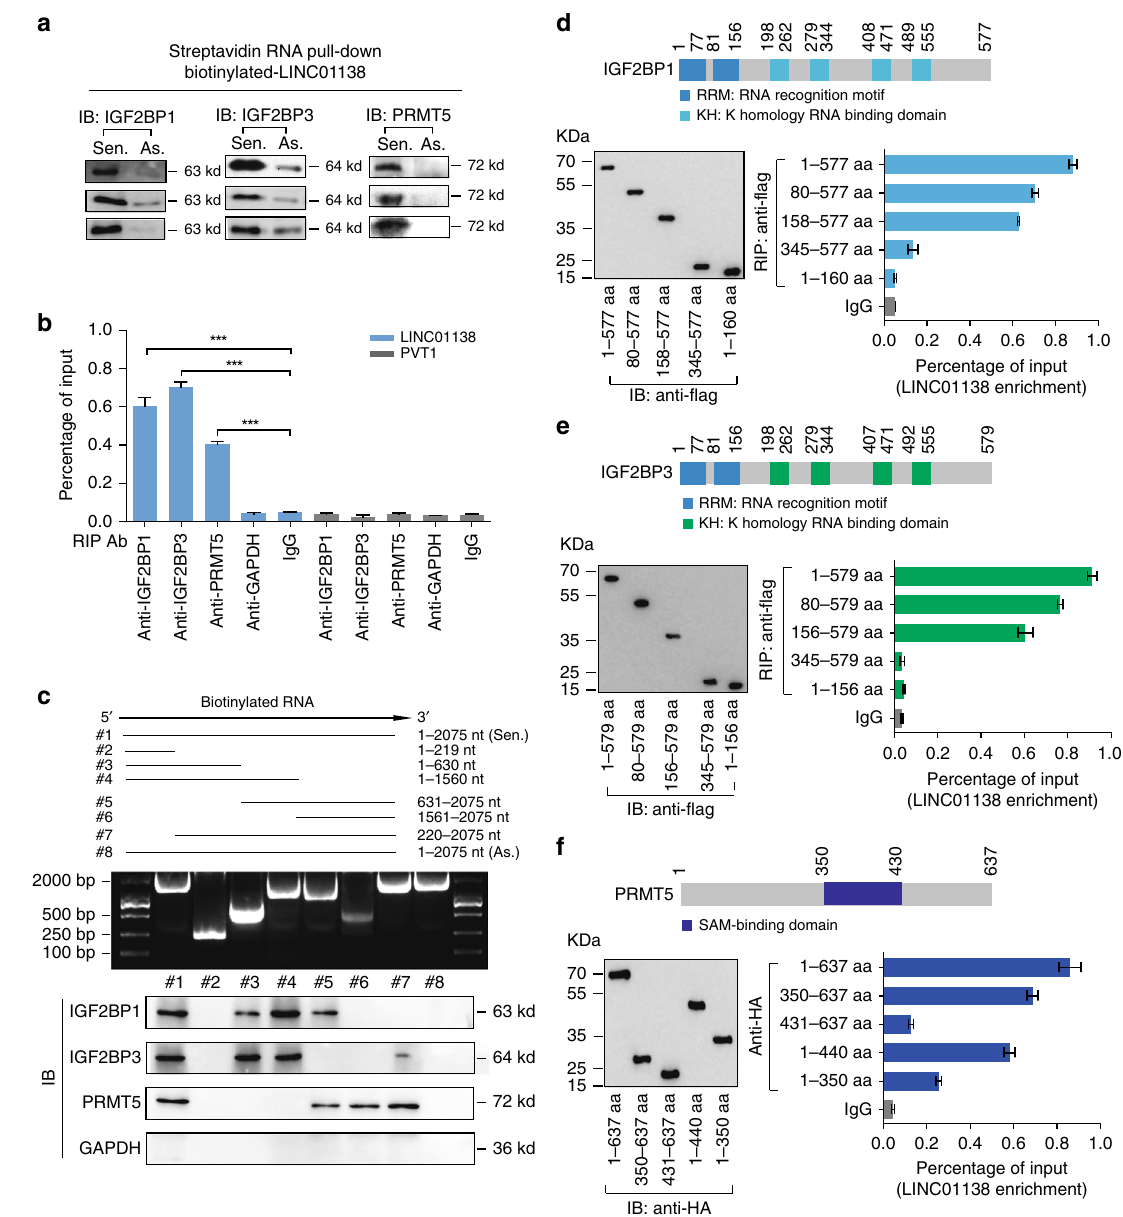
Fig. 3 LINC01138 physically interacts with IGF2BP1, IGF2BP3 and PRMT5 in HCC cells. a Immunoblotting for the speci fi c associations of IGF2BP1, IGF2BP3 or PRMT5 with biotinylated-LINC01138 from three independent streptavidin RNA pull-down assays. b RIP assays were performed using the indicated antibodies. Real-time PCR was used to detect LINC01138 enrichment, using GAPDH antibody as the antibody control and 2036-nt PVT1 as the LincRNA control. c Immunoblotting of IGF2BP1, IGF2BP3 or PRMT5 in pull-down samples by full-length biotinylated-LINC01138 (#1) or truncated biotinylated- LINC01138 RNA motifs (#2: 1 – 219 nt; #3: 1 – 630 nt; #4: 1 – 1560 nt; #5: 630 – 2075 nt; #6: 1560 – 2075 nt; #7: 220 – 2075 nt), with GAPDH as the negative control. d – f Deletion mapping for the domains of IGF2BP1 ( d ), IGF2BP3 ( e ) or PRMT5 ( f ) that bind to LINC01138. RIP analysis for LINC01138 enrichment in cells transiently transfected with plasmids containing the indicated FLAG-tagged or HA-tagged full-length or truncated constructs. Values are expressed as the mean ± SEM, n = 3 in b , d –